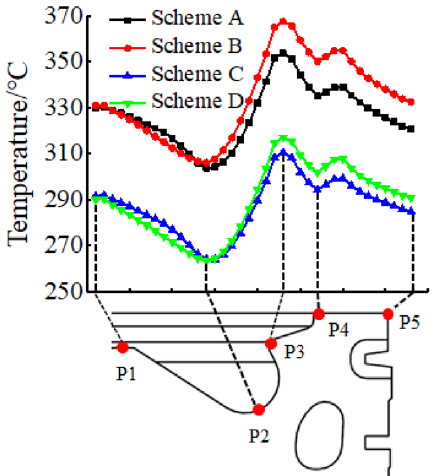
Figure 9. Radial temperature distribution on the top surface of the